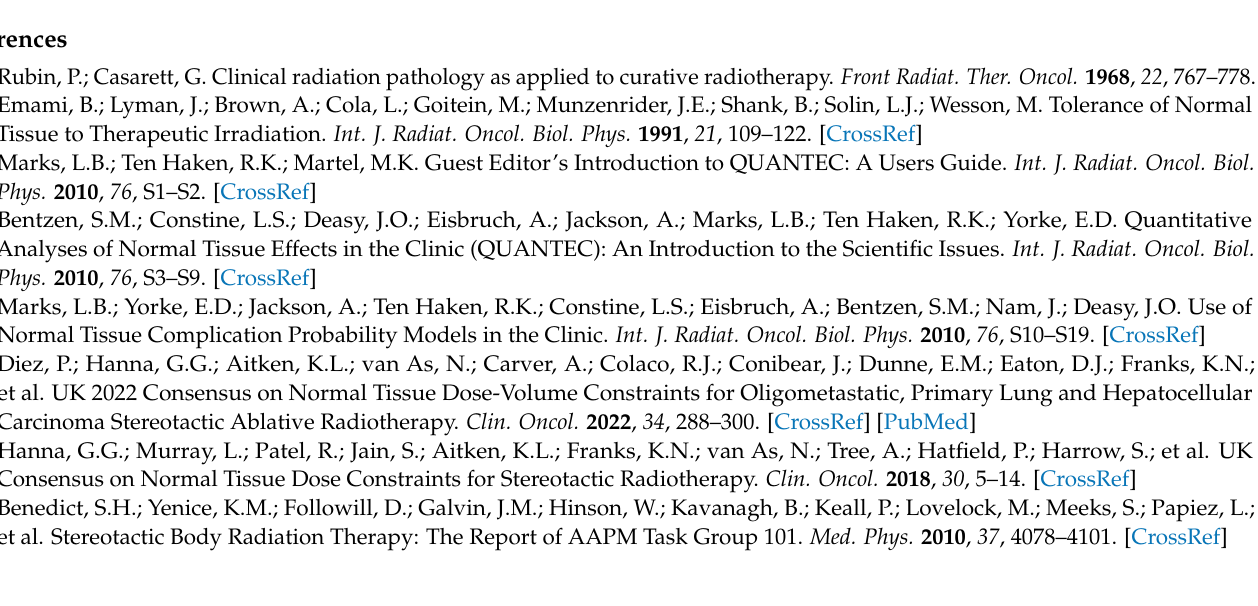
Supplementary Table S2: (DVCs for RT of Hodgkin’s lymphoma), Supplementary Table S3: (DVCs for RT of breast cancers), Supplementary Table S4: (DVCs for RT of pediatric tumors), Supplementary Table S5: (DVCs for stereotactic ablative RT of ventricular arrythmia)